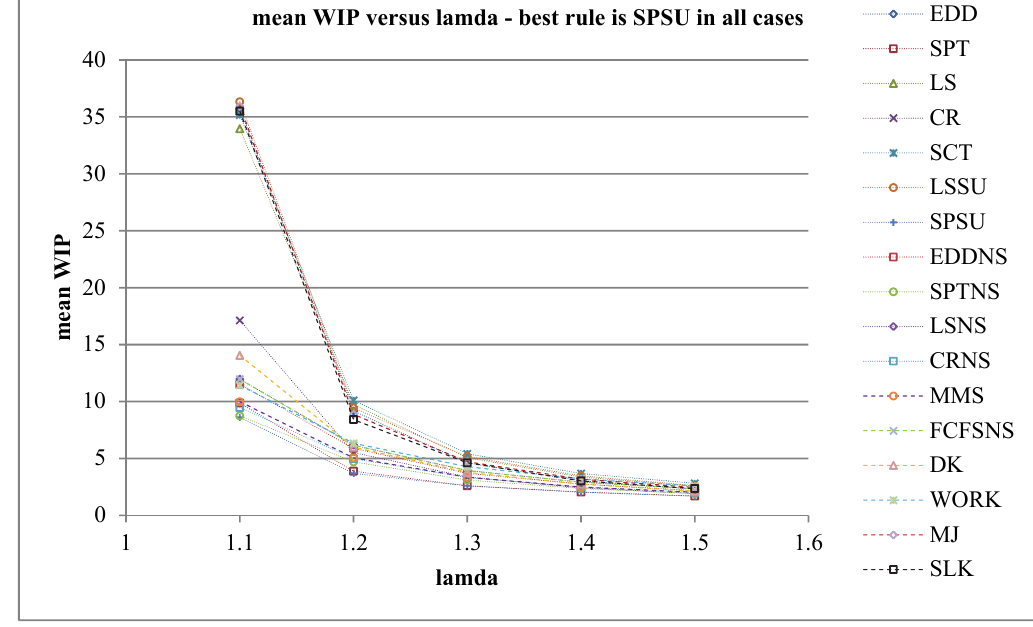
Fig. 1. Mean WIP for simulation cases 1 -